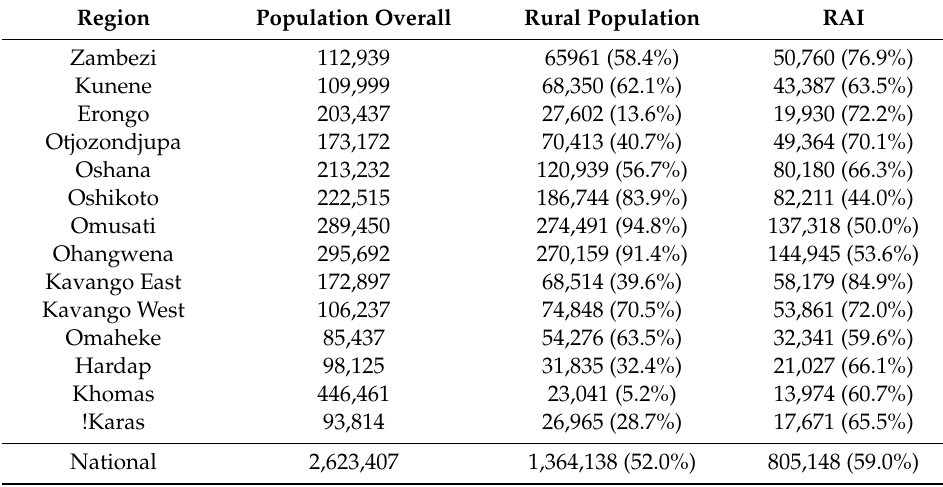
Table 9. 2 km RAI estimated per region with Facebook’s High Density Population Map 2018 and SNIC segmentation.